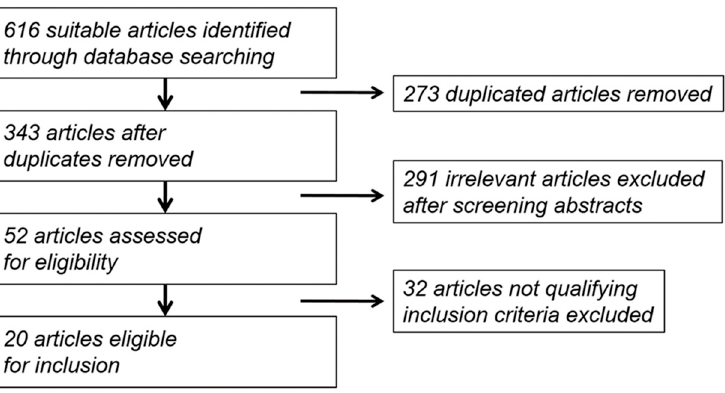
Figure 1. Flow diagram of the reviewed literature. Table 1. Characteristics of the studies included in the meta-analysis.